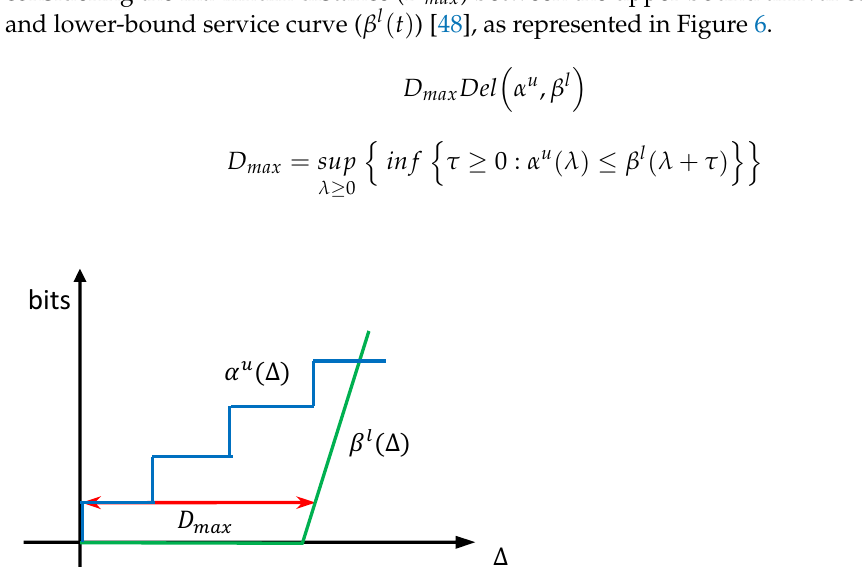
Figure 5. Examples of upper and lower bounds: ( a ) the arrival curve and ( b ) the service curve for a periodic time division multiple access (TDMA) system.